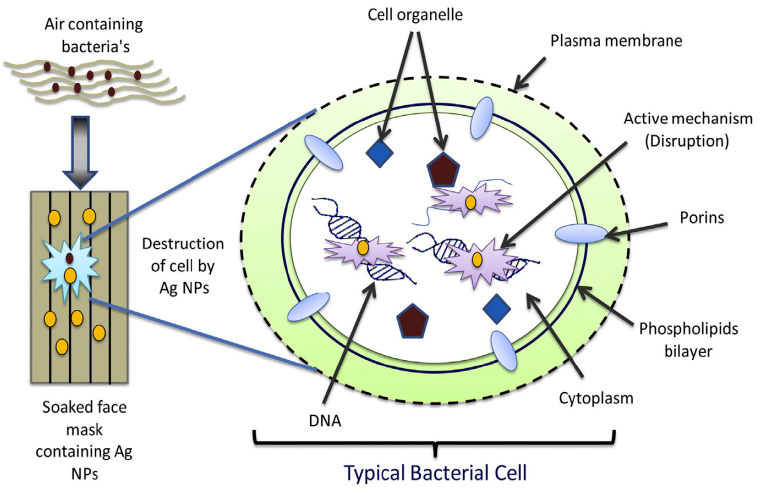
Figure 5. Antimicrobial effects after incorporation with silver nanoparticles [41], reproduced with permission. Copyright Elsevier Ltd.